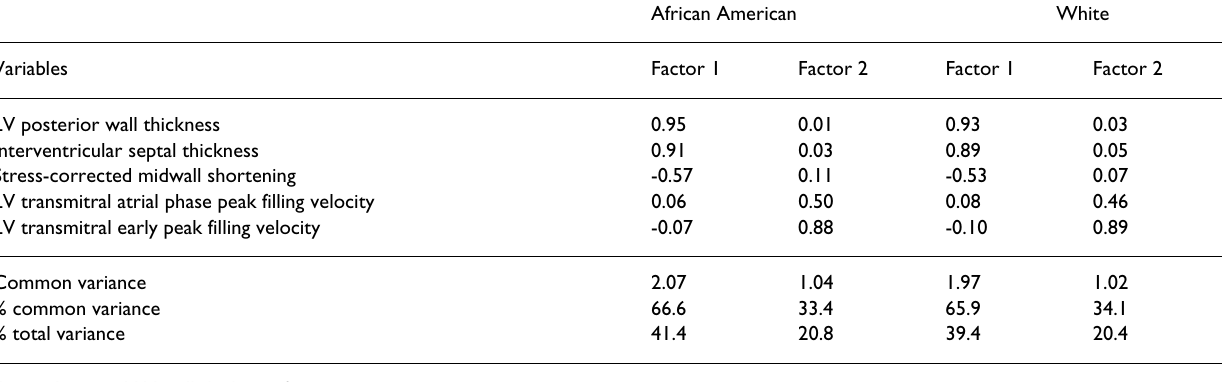
Table 3: Factor Loading Pattern in the Final Factor Analysis Models